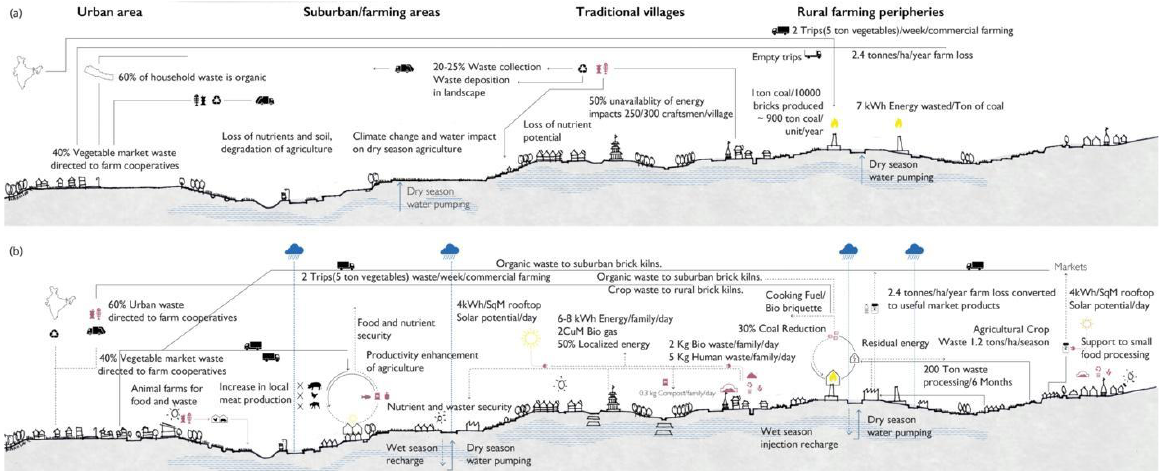
Figure 9. Envisioning a systemic transition to generate shorter loops and directing resource flows into meaningful processes. (a) Existing systemic sections interpreting the existing linear cycles and flows of resources; (b) Proposed systemic change helps in closing resource loops and promote resilience within the rural landscape. Source: